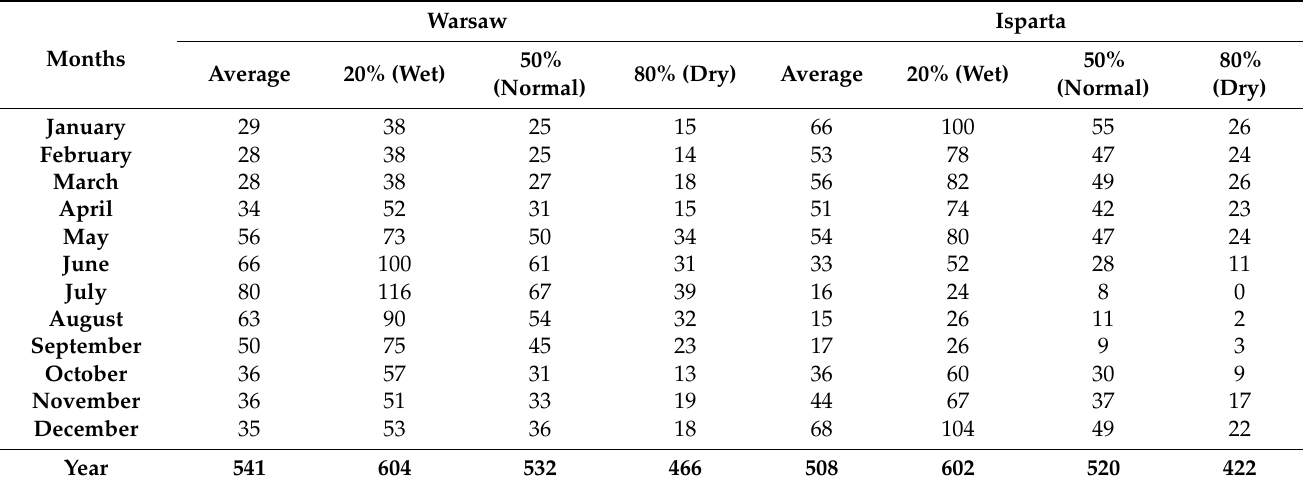
Table 1. Monthly and annual rainfall analysis results in Warsaw and Isparta